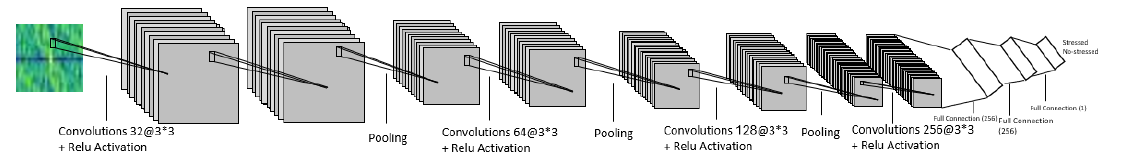
Figure 6. Stress classification using a convolution neural network (CNN) model